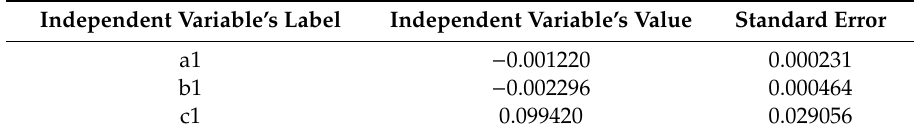
Table 3. Evaluation of fixed parameters for model 1.